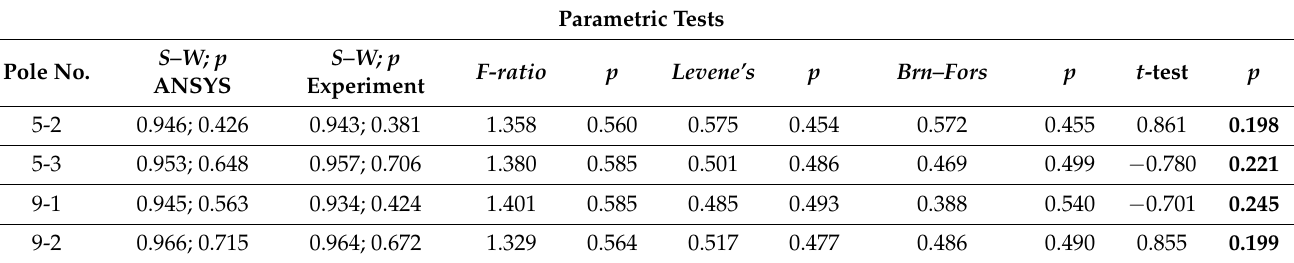
Table 5. Testing differences between ANSYS model and experimental load–deflection graphs for tested poles.